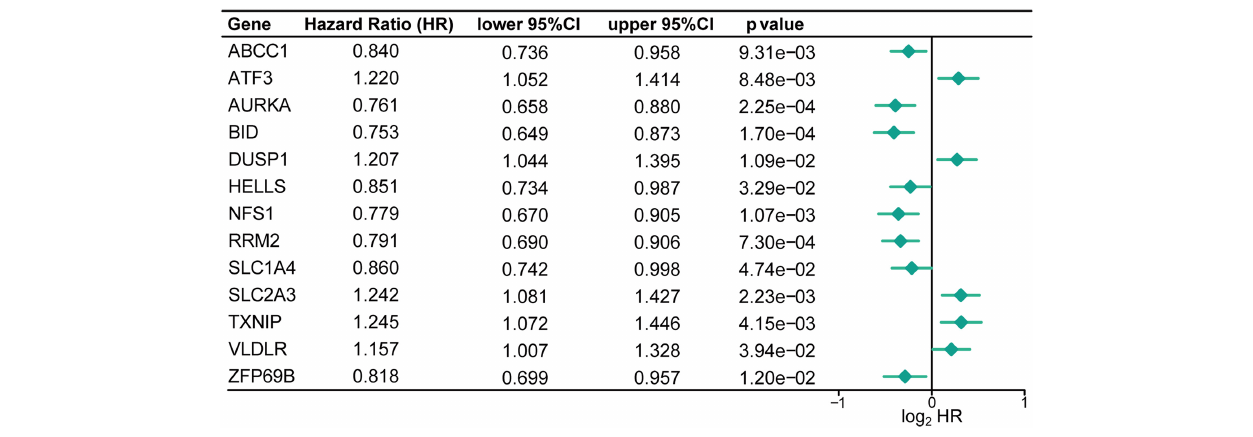
FIGURE 2 | Identification of the FRGs with prognostic value in patients with CC. Forest plots shows the differentially expressed FRGs identified by univariate Cox regression analysis that can predict overall survival in patients with